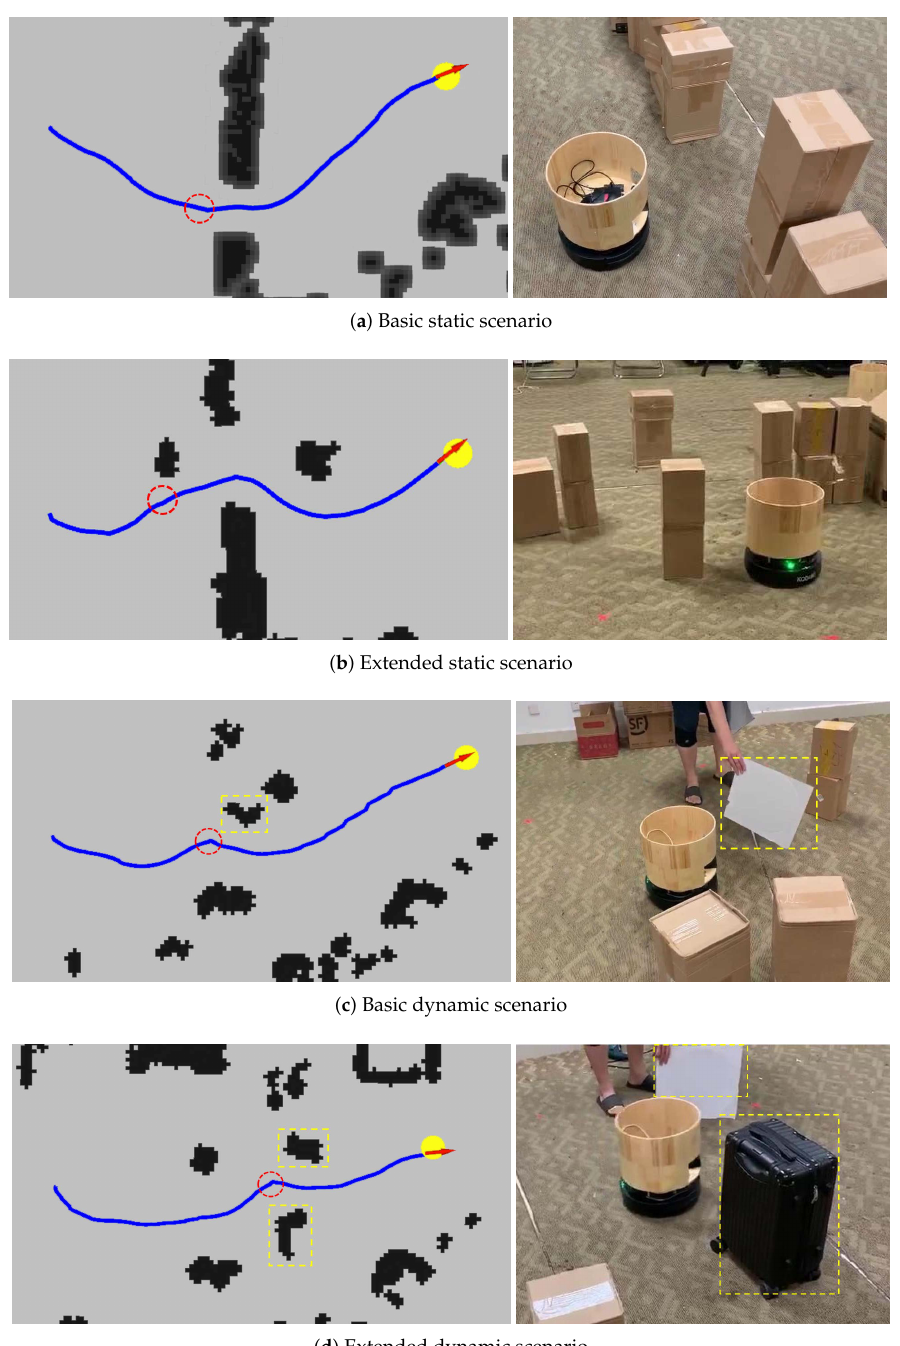
Figure 16. ( a ) The basic static scenario, where some paper boxes are places as static obstacles to block the robot’s path from its starting position to its target. ( b ) The extended static scenario, where two obstacles are added to the front and the rear of the narrow opening of a line of obstacles. ( c ) The basic dynamic scenario, where cardboard appears suddenly in the moving path of the robot. ( d ) The extended dynamic scenario, where cardboard appears suddenly and a luggage moves across the path of the robot. Subfigures on the left show the trajectories and the grid maps of the robot. Subfigures on the right show the environments in the real world, which correspond to situations that the robot is at the place of the red circle in corresponding left figures. Yellow bounding boxes in the figures denote corresponding dynamic obstacles in the